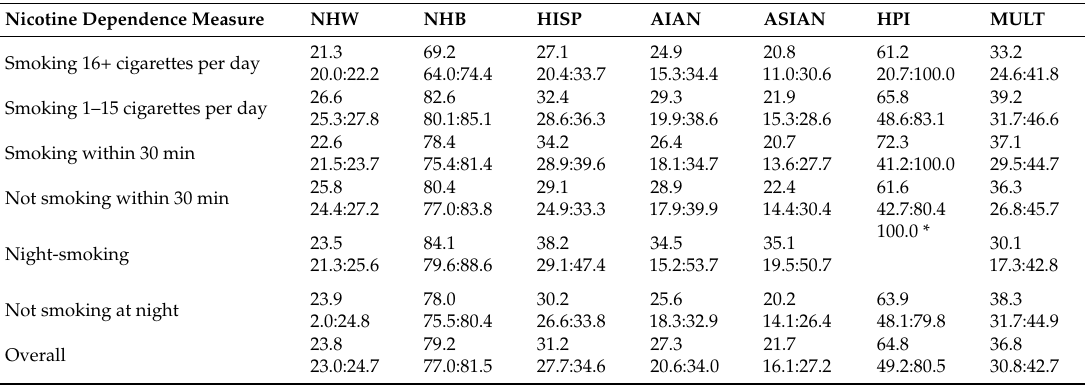
Table 2. Proportions (%, with 95% confidence intervals) of menthol smokers for each level of nicotine dependence and